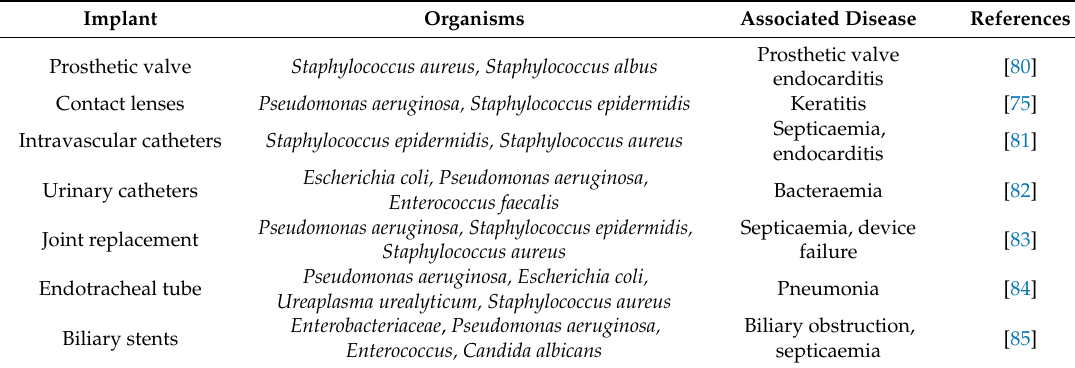
Table 2. Examples of implant